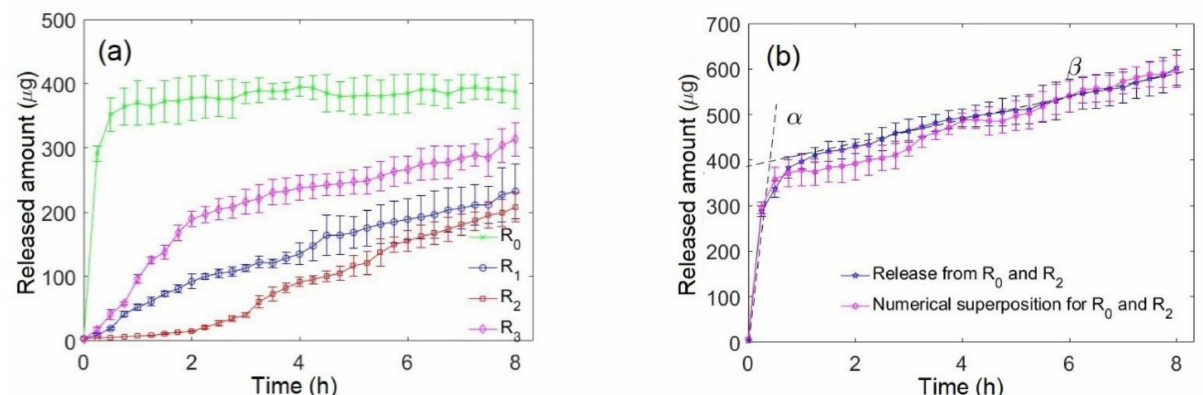
Figure 3. The kinetics of FD release from the rolled-up capsules. ( a ) Monophasic release from a single reservoir formed at different radial positions inside the capsules. ( b ) Biphasic release of FD from reservoirs R 0 and R 2 . The two phases are symbolically designated by the lines α and β